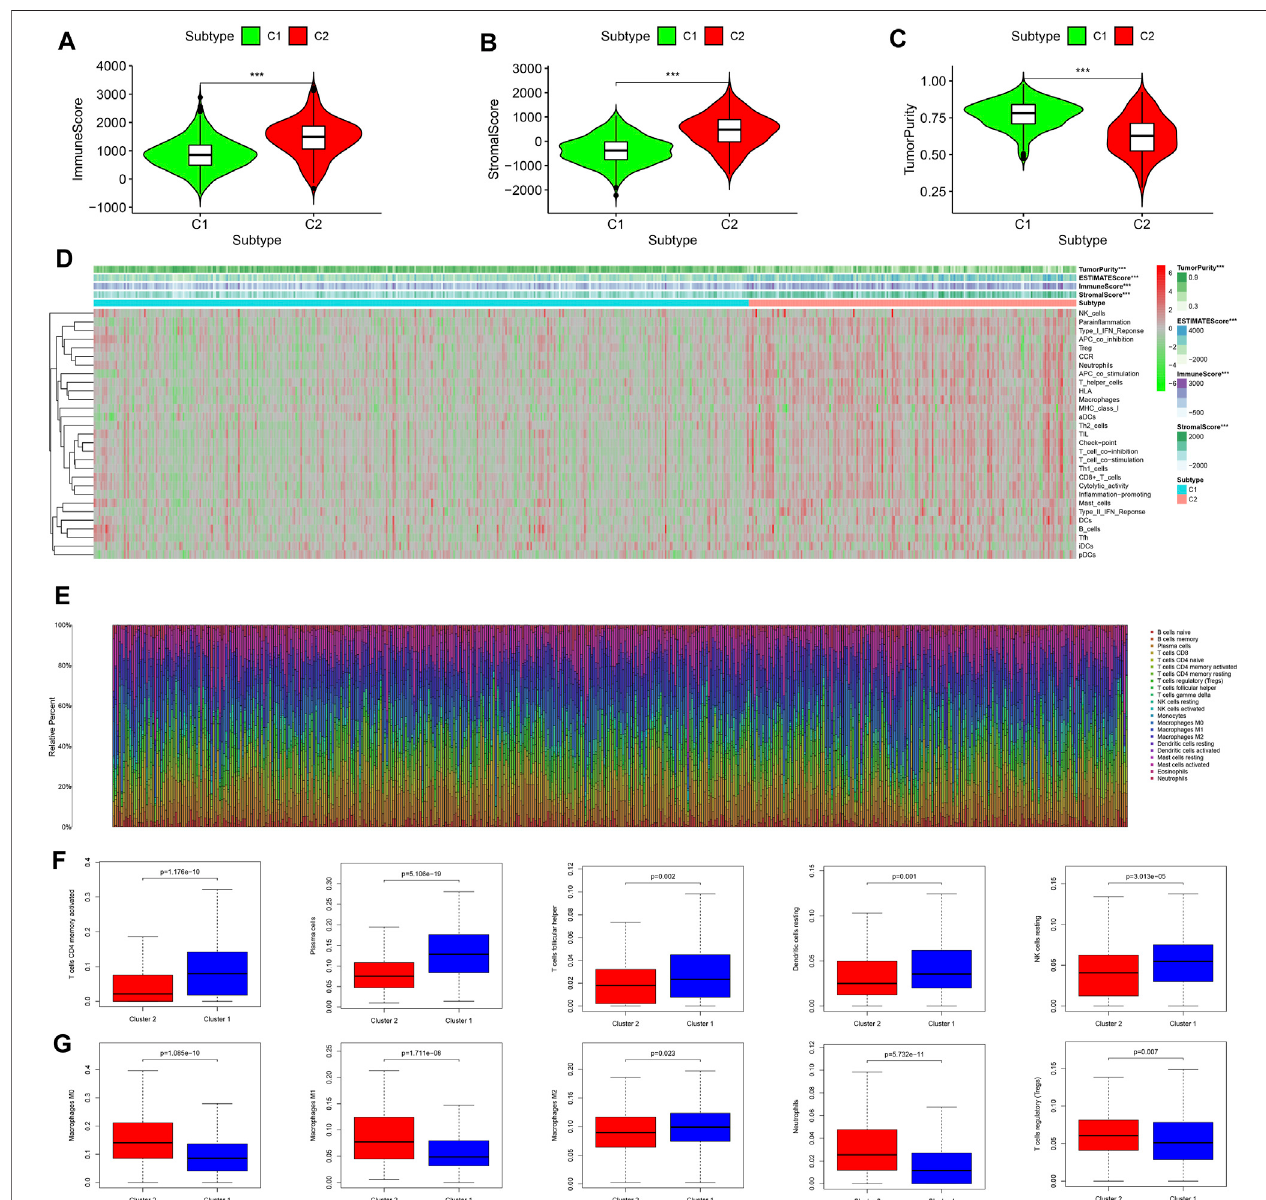
FIGURE 4 | Comprehensive analysis of the tumor microenvironment status and immune in fi ltration across two molecular subtypes. (A) Immune scores of the two molecular subtypes. (B) Stromal scores of the two molecular subtypes. (C) Tumor purity status of the two molecular subtypes. (D) Heat map of ssGSEA scores for the two molecular subtypes. (E) The in fi ltration density of 22 immune cells in each sample. (F) Immune cells with higher fraction in subtype 1 (C1). (G) Immune cells with higher fraction in subtype 2 (C2). ssGSEA, single-sample gene set enrichment analysis.